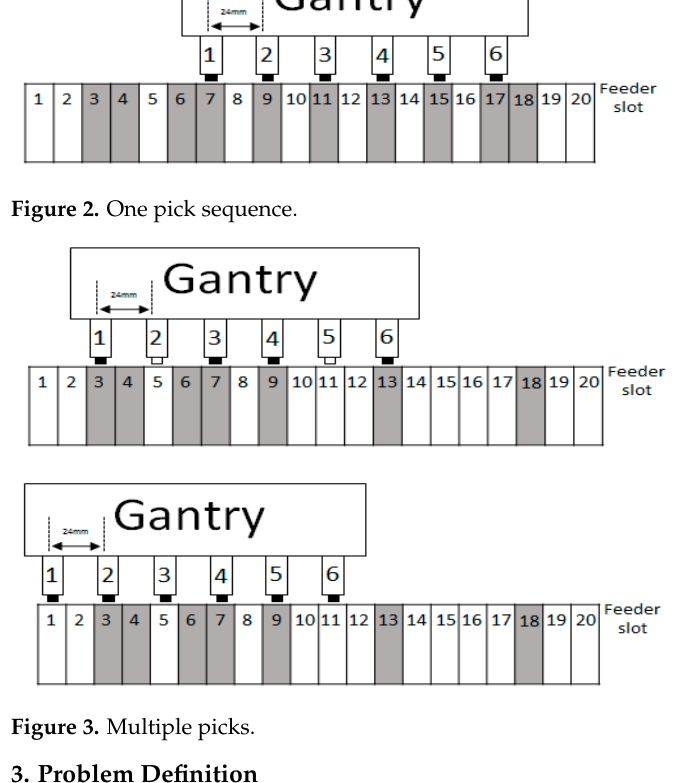
Figure 3. Multiple picks.